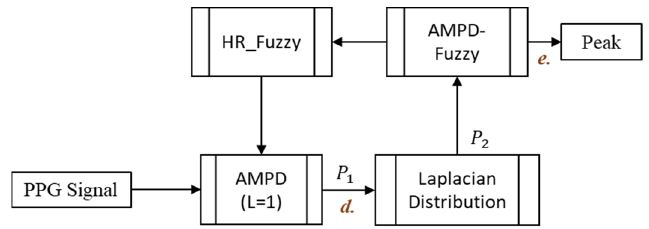
Figure 9. The block diagram of the AMPD-Fuzzy.